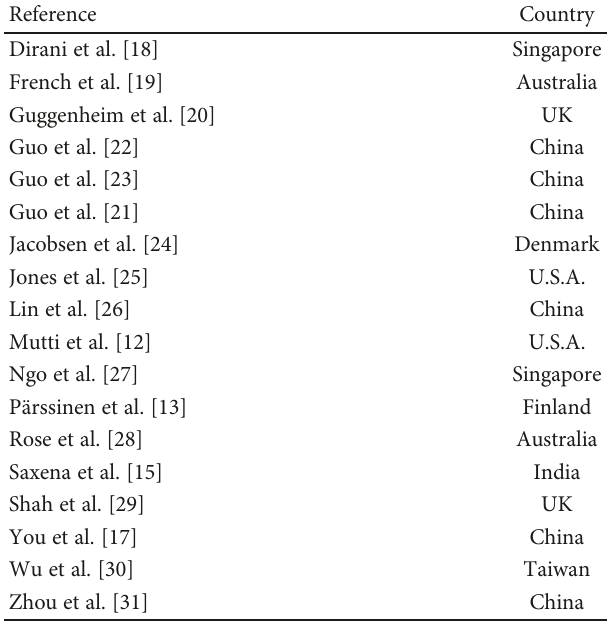
Table 2: Dependence between outdoor activity and